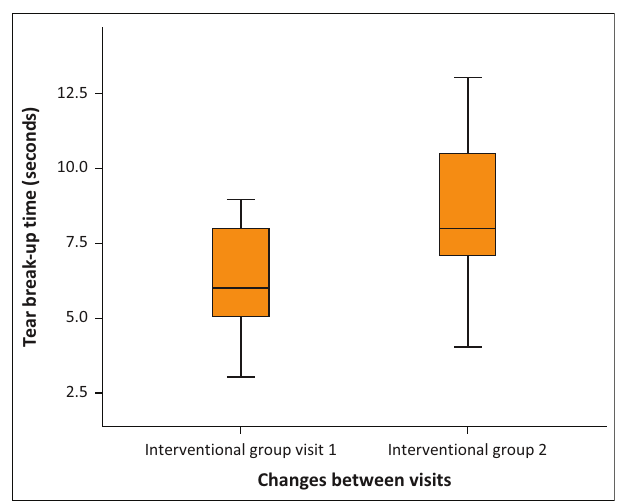
FIGURE 5: Box plots for tear film break-up time measurements for the intervention group. Significant changes between